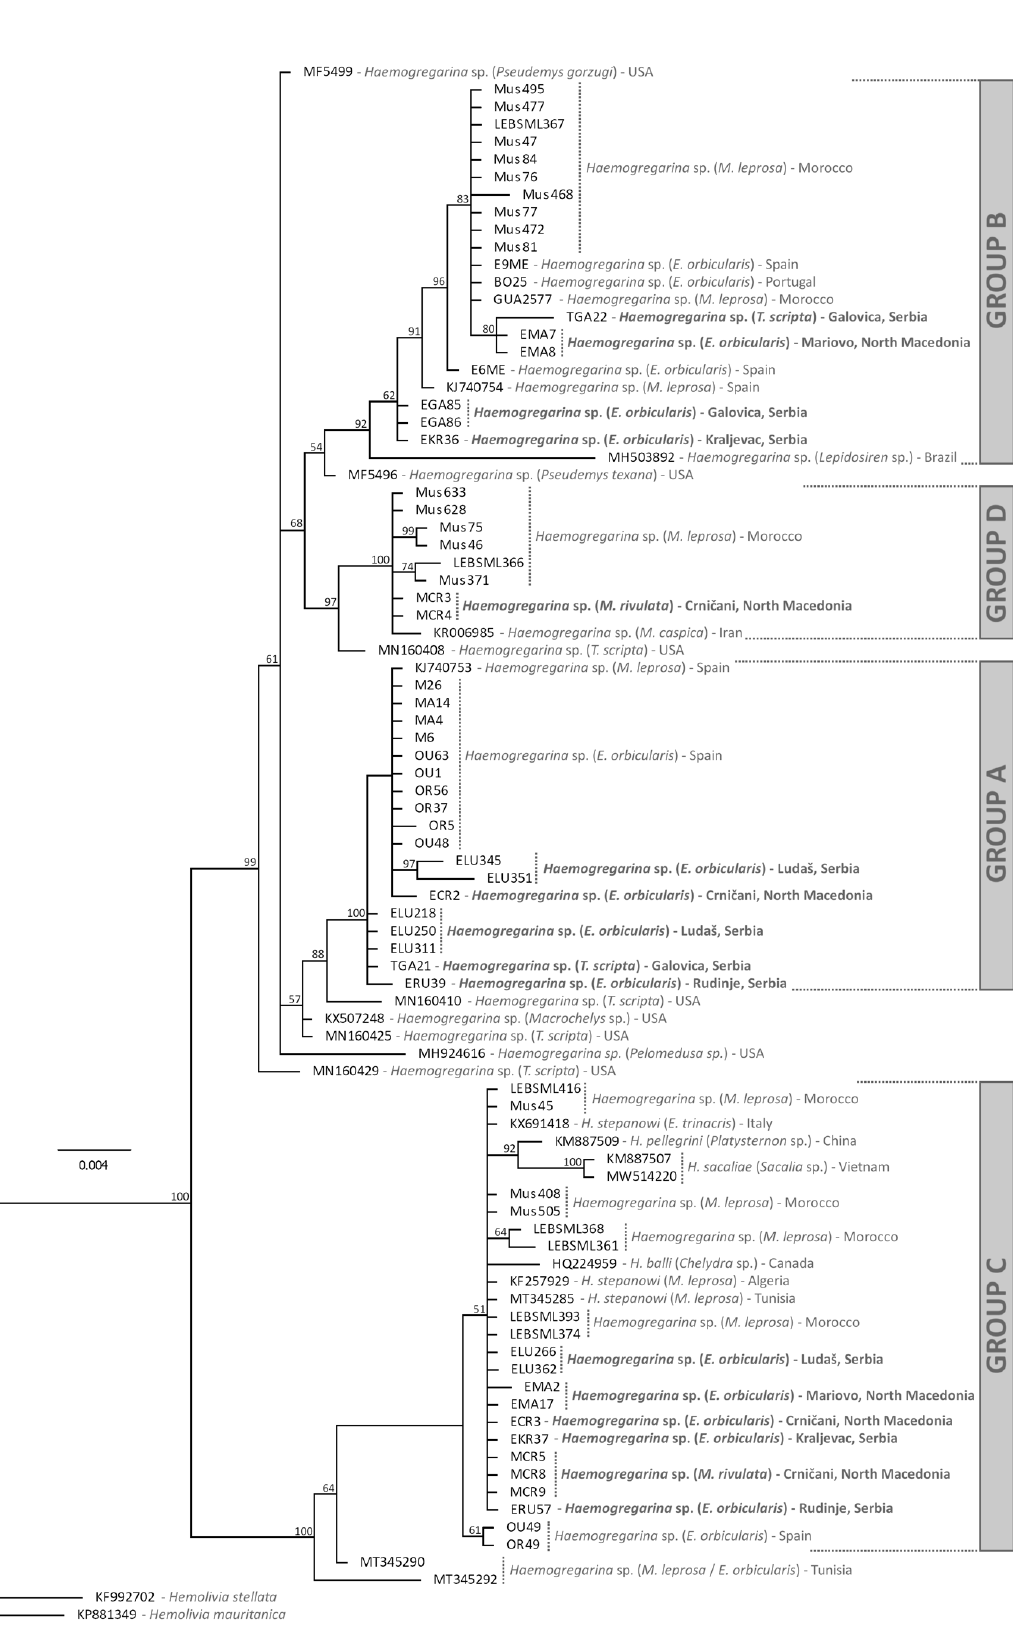
Figure 2. Estimate of phylogenetic relationships of the Haemogregarina detected based on Bayesian inference of partial 18S rRNA sequences. Values next to nodes indicate % Bayesian Posterior Probabilities. The tree was rooted using two examples from the genus Hemolivia .